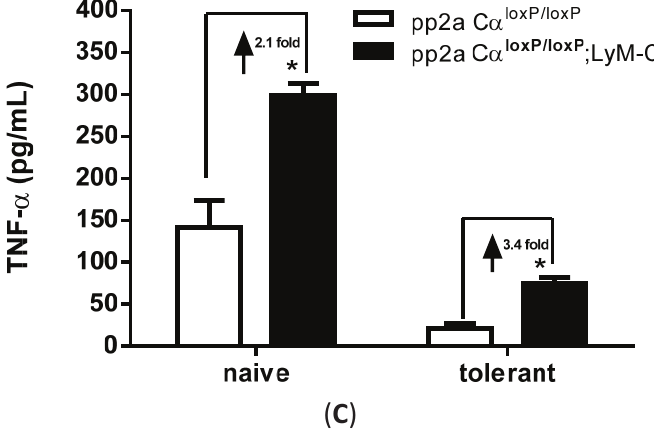
Figure 4. Increased TNF-(cid:2) secretion from PP2AC(cid:2) conditional knockout macrophages under both naïve and tolerant conditions. Elicited peritoneal macrophages were isolated